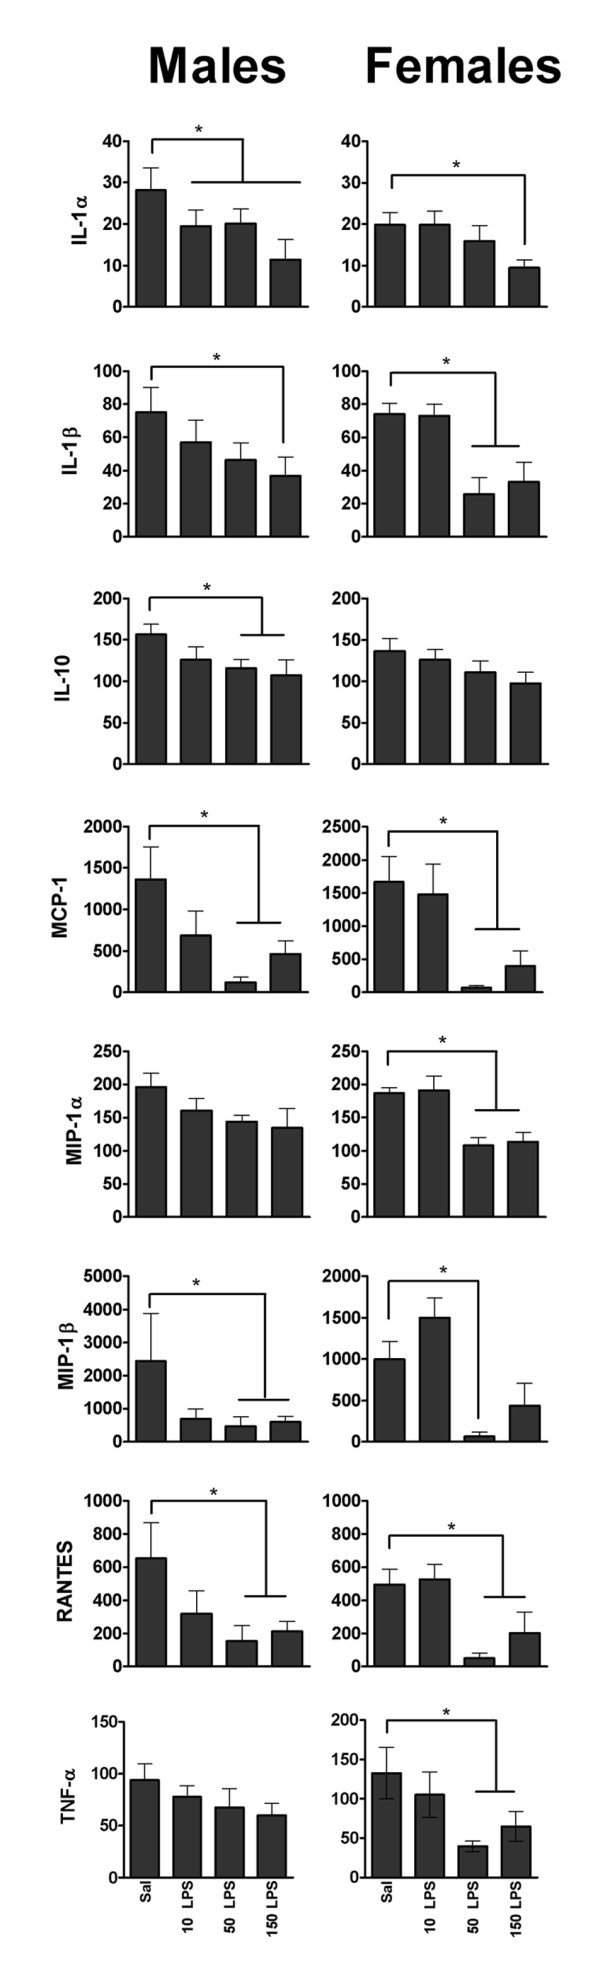
Serum cytokine concentrations (pg/mL) of adult offspring from each maternal treatment group 3.5 hours after LPS challenge. MPSI caused blunted release of predominantly innate-type cytokines in challenged offspring. A selection is shown here; the remaining cytokines are shown in Figure S3 in Additional file 4. All values represent means ± SEM. *P ≤ 0.05 vs. control independent of maternal origin and litter size (n = 6 mothers per treatment). Maternal treatments: Sal = saline; 10 LPS = 10 μg/kg LPS; 50 LPS = 50 μg/kg LPS; 150 LPS = 150 μg/kg LPS.